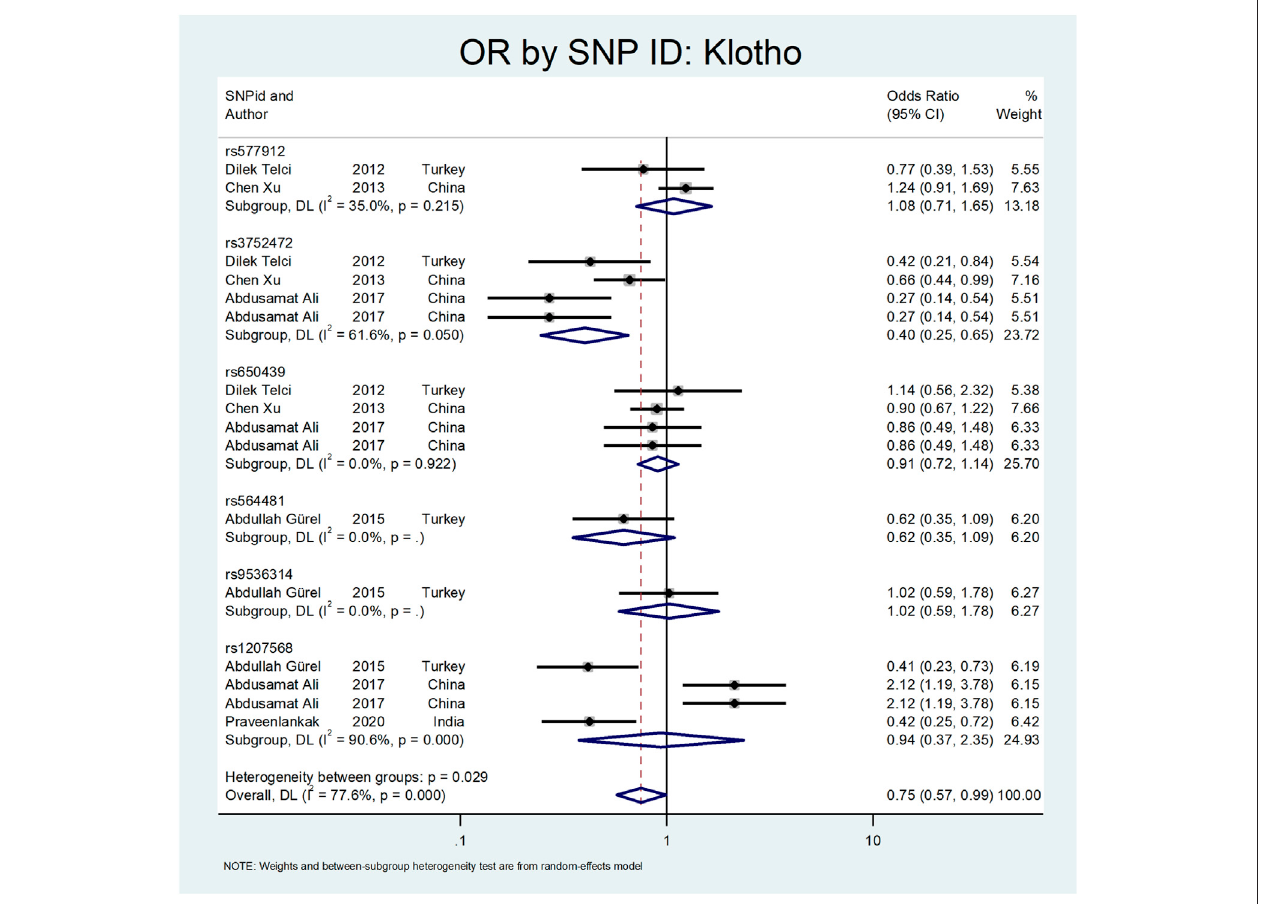
FIGURE 9 | Subgroup analysis for Klotho, by SNP